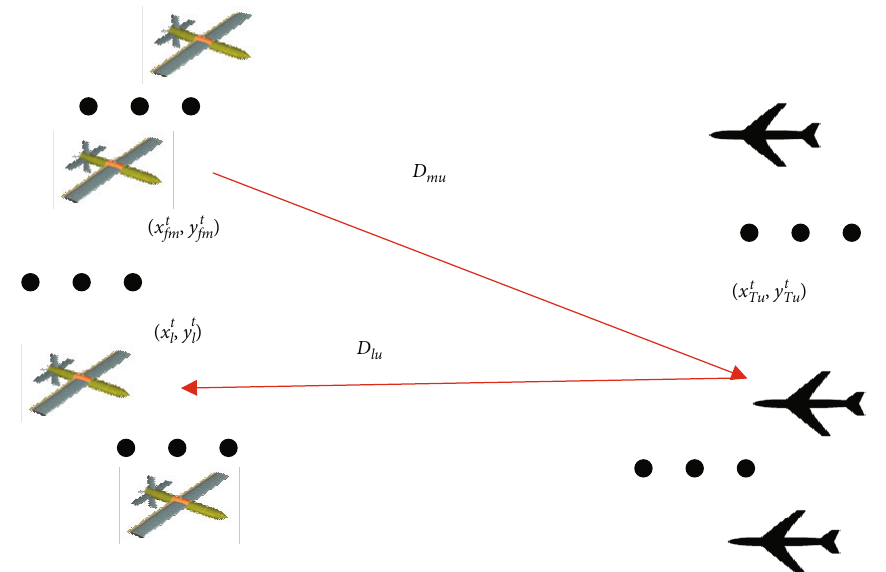
Figure 2: Schematic diagram of single